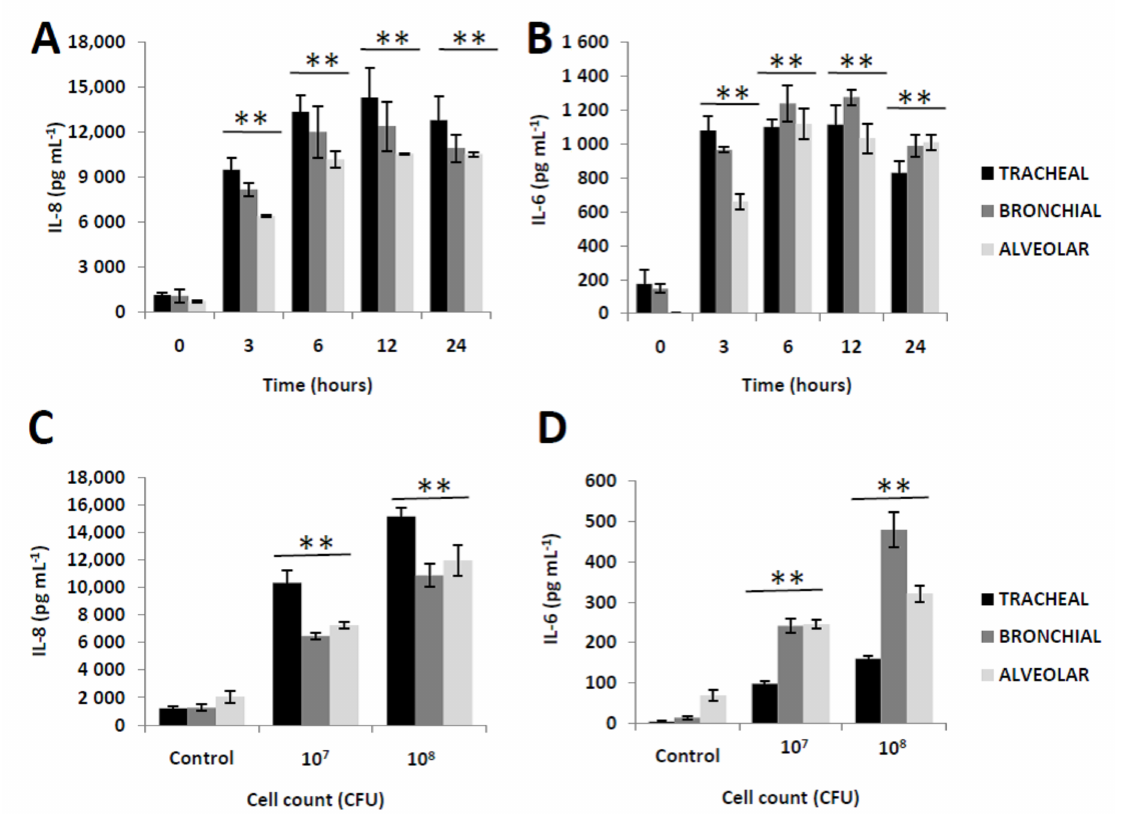
Figure 1. Inflammatory responses associated to heat-killed Fusobacterium nucleatum are a ff ected by bacterial incubation time and cell count. Assay measurements of secreted IL-8 and IL-6 from human primary tracheal, bronchial, and alveolar epithelial cells incubated with heat-killed F . nucleatum (1.0 × 10 8 CFU mL − 1 ) are specified. ( A ) Secreted IL-8 and ( B ) IL-6 amounts at varying incubation times areshown. ( C )SecretedIL-8and( D )IL-6underthesameinfectiontimepoint(12h)anddi ff erentbacterial cell concentration are indicated. The results presented are the mean ± SD utilizing two replicates of three independent samples. Statistical analyses were performed using an Andersen–Darling normality test to check whether the values obtained were normalized ( p > 0.05) and, if passed, matched-pair t -test (** p <